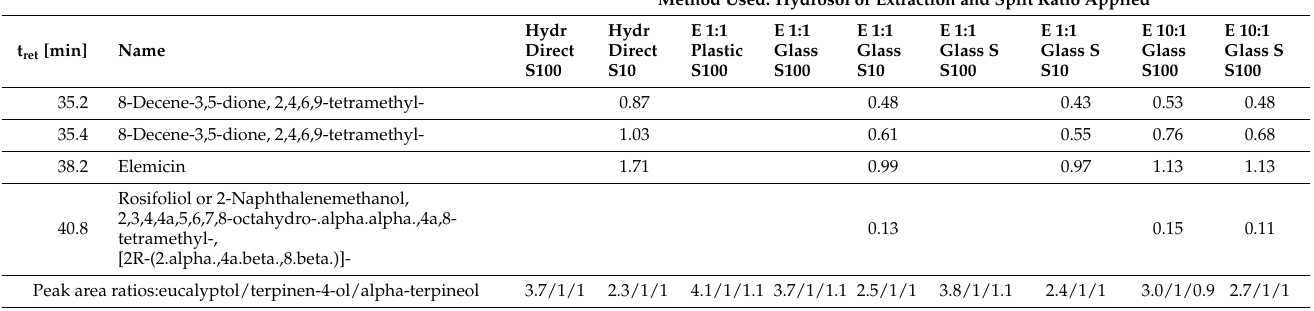
Method Used: Hydrosol or Extraction and Split Ratio Applied *